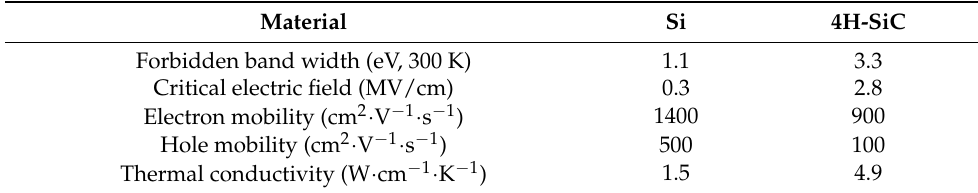
Table 1. Some main parameters of Si and SiC materials.